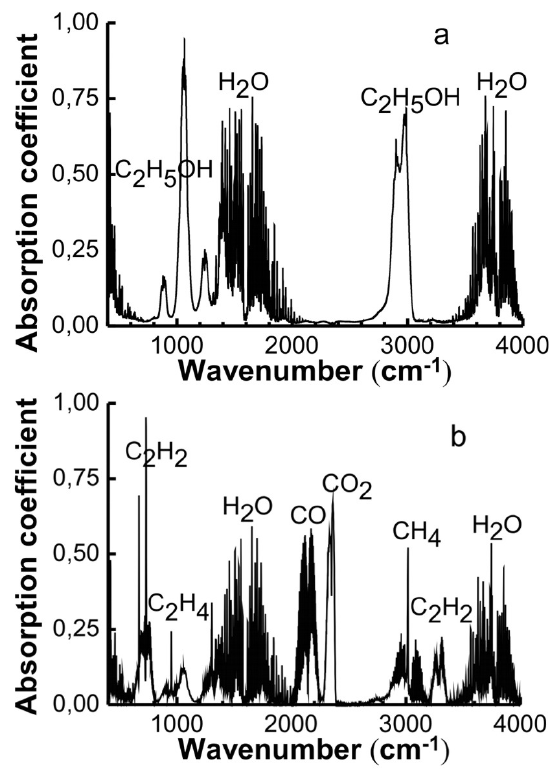
Figure 2: Absorption IR-spectra of mixtures at inlet (a) and outlet (b) of plasma